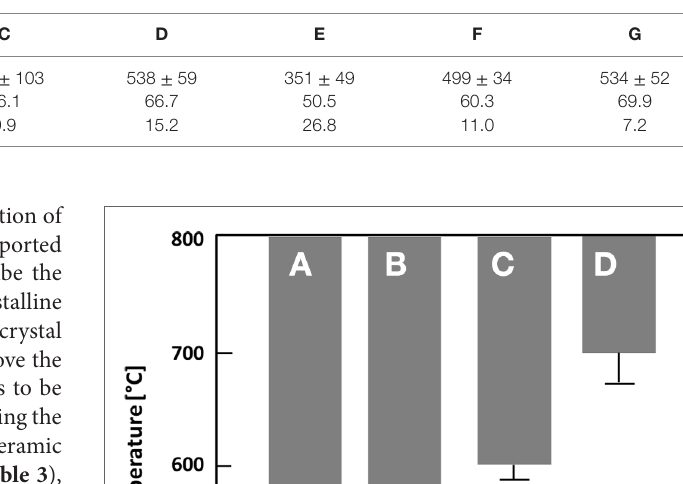
TaBle 4 | Mechanical and optical properties of the glass–ceramics.